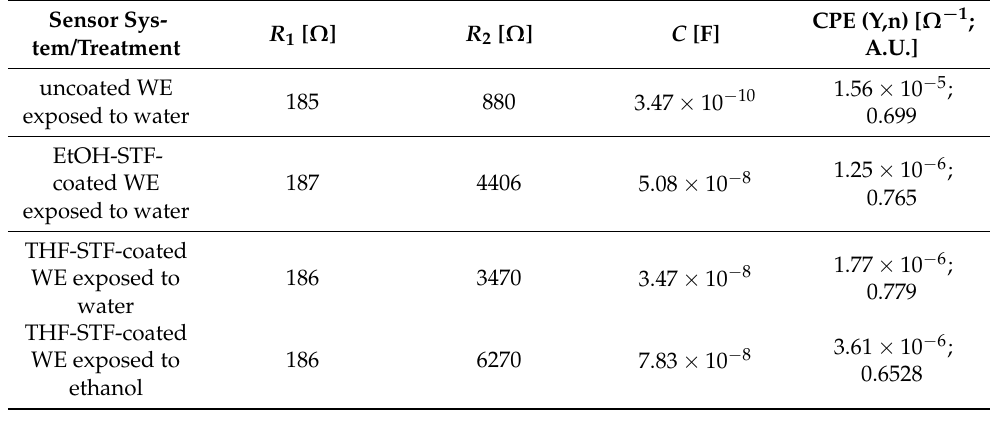
Table A1. Fitting parameters of the equivalent circuit shown in Figure 1d. The surface area of all the WEs was 0.5 cm 2 . R 1 and R 2 denote the resistance elements, C the capacitance element, CPE the constant phase element (Y for admittance (in Ω − 1 ), and n the phase parameter (in A.U.)).